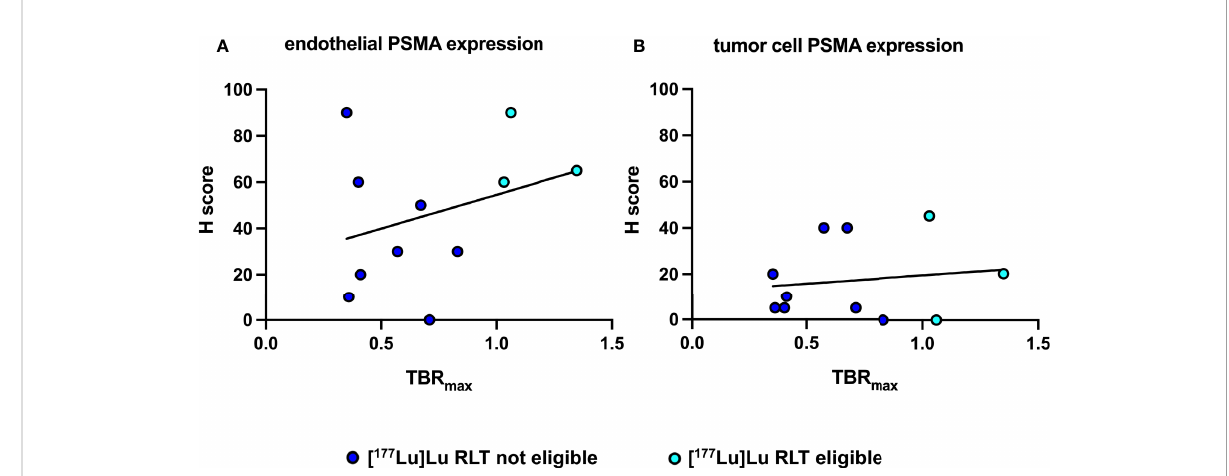
FIGURE 2 Correlation and simple linear regression analysis of immunohistochemical PSMA expression and [ 68 Ga]Ga-PSMA uptake of patients eligible and not eligible for [ 177 Lu]Lu RLT. (A) Between endothelial PSMA expression and [ 68 Ga]Ga-PSMA uptake, f = 1.03 and p = 0.34 (B) Between tumor cell PSMA expression and [ 68 Ga]Ga-PSMA uptake, f = 0.17 and p =